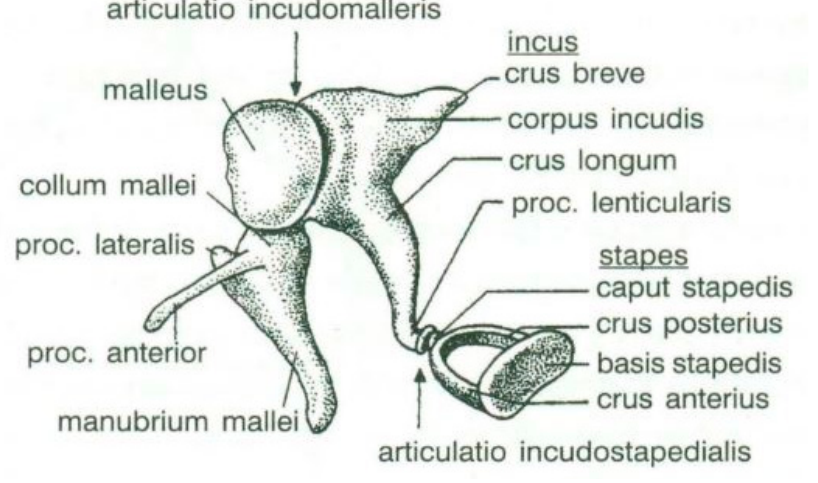
Figure 1. The ossicular chain of human ear. Source: adapted from Stropus et al. [2].